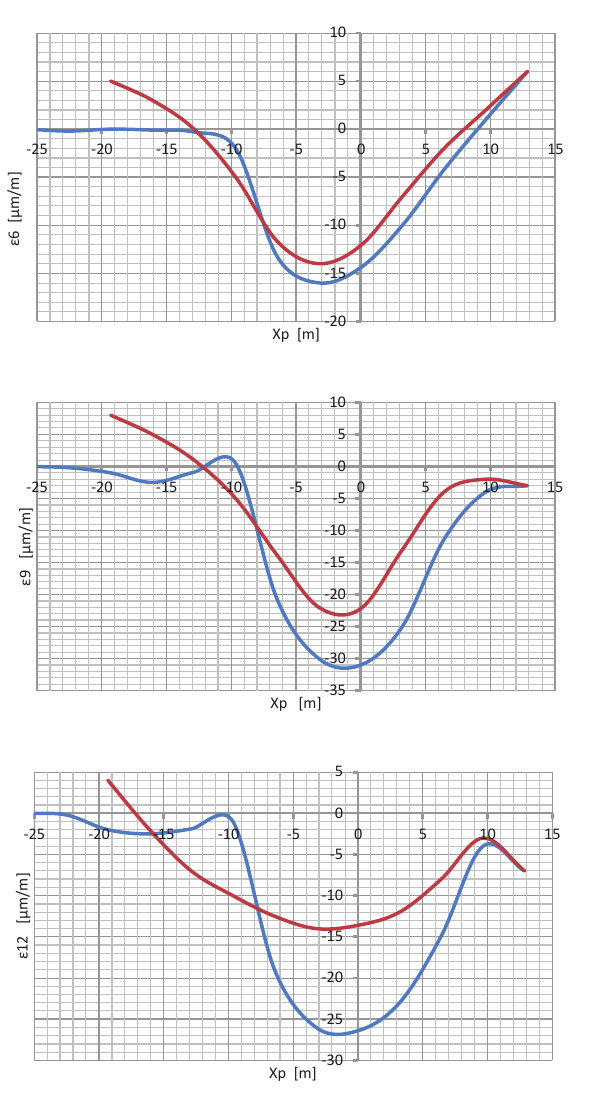
( x ) for three points in the shell crown zone. Fig 6 Figure 6: Functions ε g p